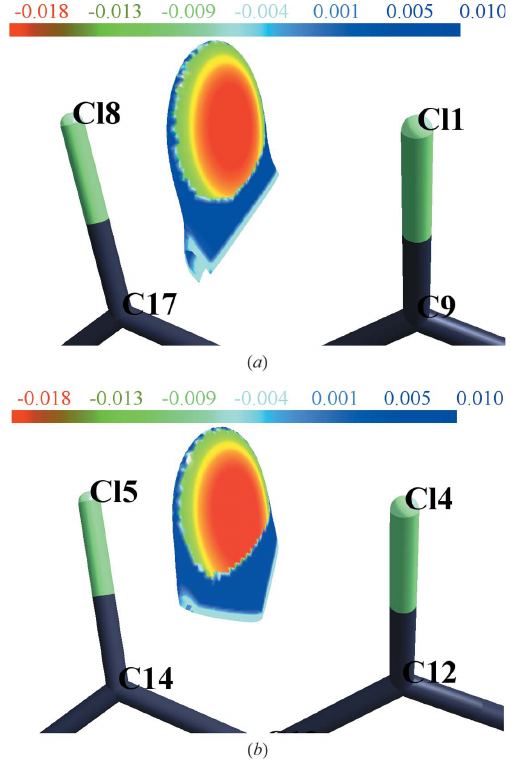
Figure 4 RDG-based NCI isosurfaces with s = 0.6 a.u. obtained from the experimental ED model for individual peri Cl (cid:2)(cid:2)(cid:2) Cl interactions. The surfaces are coloured on a red–green–blue scale [ (cid:6) 0.02 < sign( (cid:7) 2 ) (cid:12) < 0.015 a.u.]. Red, green and blue indicate stabilizing, intermediate and destabilizing overlap regions, respectively. Sarkar and Row (cid:3) Peri versus intermolecular interactions in naphthalene 41